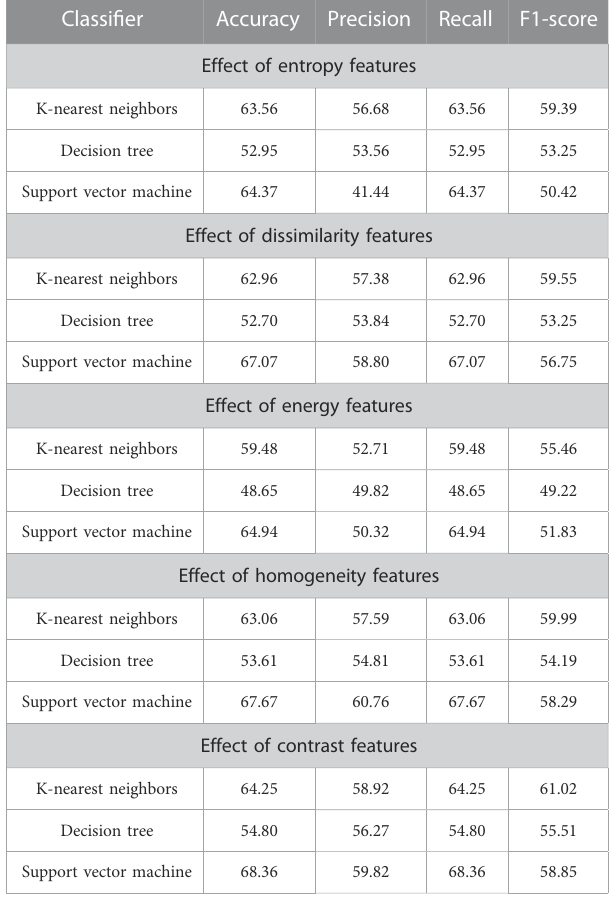
TABLE 6 Impact of different co-occurrence features on the classi fi cation of essential gene sequences of AT, DOM, DR, HS, and MM species. Classi fi